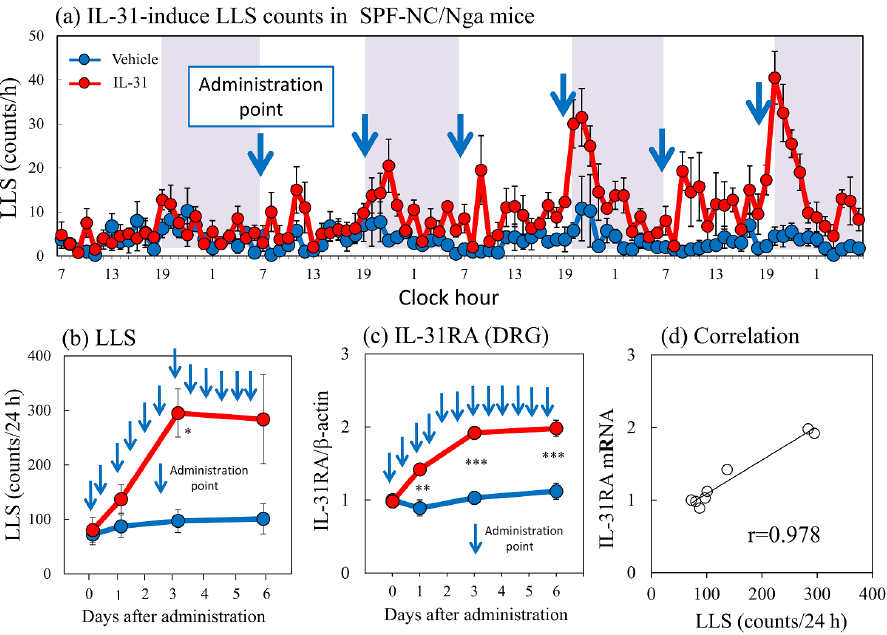
Figure 5. Effect of repeated administration of IL-31 on long-lasting scratching (LLS) counts and dorsal root ganglion (DRG) neuronal IL-31RA mRNA expression in SPF-NC/Nga mice. ( a ) LLS counts induced by repeated intradermal (i.d.) administration of IL-31 in NC/Nga mice. Repeated injection of IL-31 (1 µ g/site, i.d.) every 12 h for 3 days gradually increased LLS counts, which increased intermittently after each dosage of IL-31. This increase in LLS counts showed a circadian rhythm; in particular, the LLS counts significantly increased at nighttime. Blue arrows indicate the administration points of vehicle or IL-31. Lateral axis indicates the clock hour, and the shaded area represents nighttime (7:00 pm to 7:00 am). ( b ) Effect of repeated administration of IL-31 on LLS counts for 6 days. ( c ) Effect of repeated administration of IL-31 on IL-31RA mRNA expression in the DRG. ( d ) Correlation between LLS counts and IL-31RA mRNA expression in the DRG (r = 0.978). Blue lines indicate vehicle (phosphate buffer solution, PBS)-administered mice, and red lines indicate IL-31 (1 µ g/site, i.d., every 12 h for 3 days)-administered mice. Each value represents the mean ± standard error (S.E.) from six mice. NS, not significant. * p < 0.05, ** p < 0.01, and *** p < 0.001 compared with the respective values in the vehicle-administered group (Student’s t -test with Bonferroni